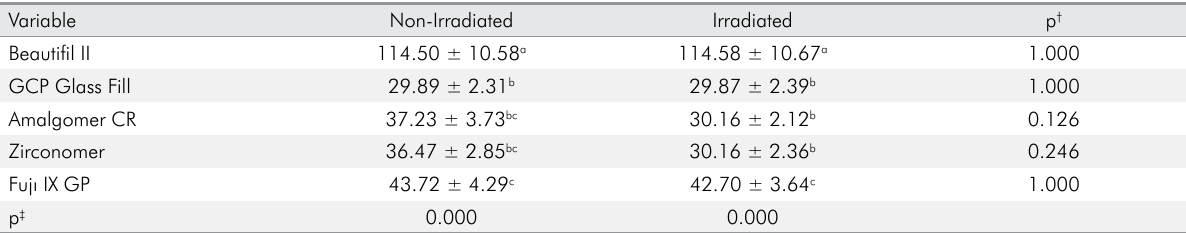
Table 4. Mean and standard deviation values of flexural strength (MPa) of the materials. Variable